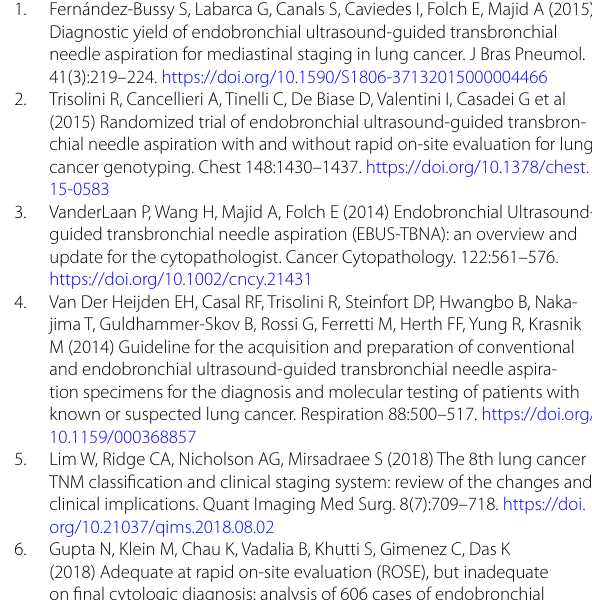
Histological classification